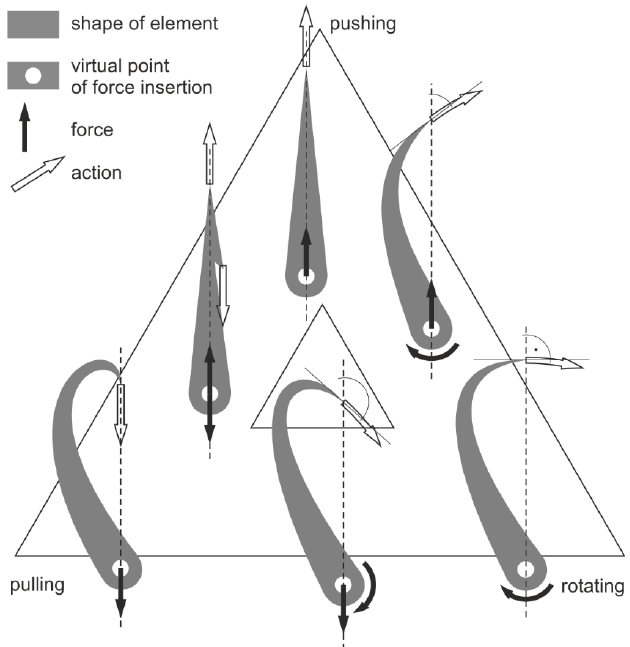
Figure 6. Shape of pointed elements in relation to their work. Two notes are important: (1) the point of force insertion can be placed outside of the element outline; (2) this point can change place during work (depending, e.g., on working muscles, especially in the case of elements anchored in a soft